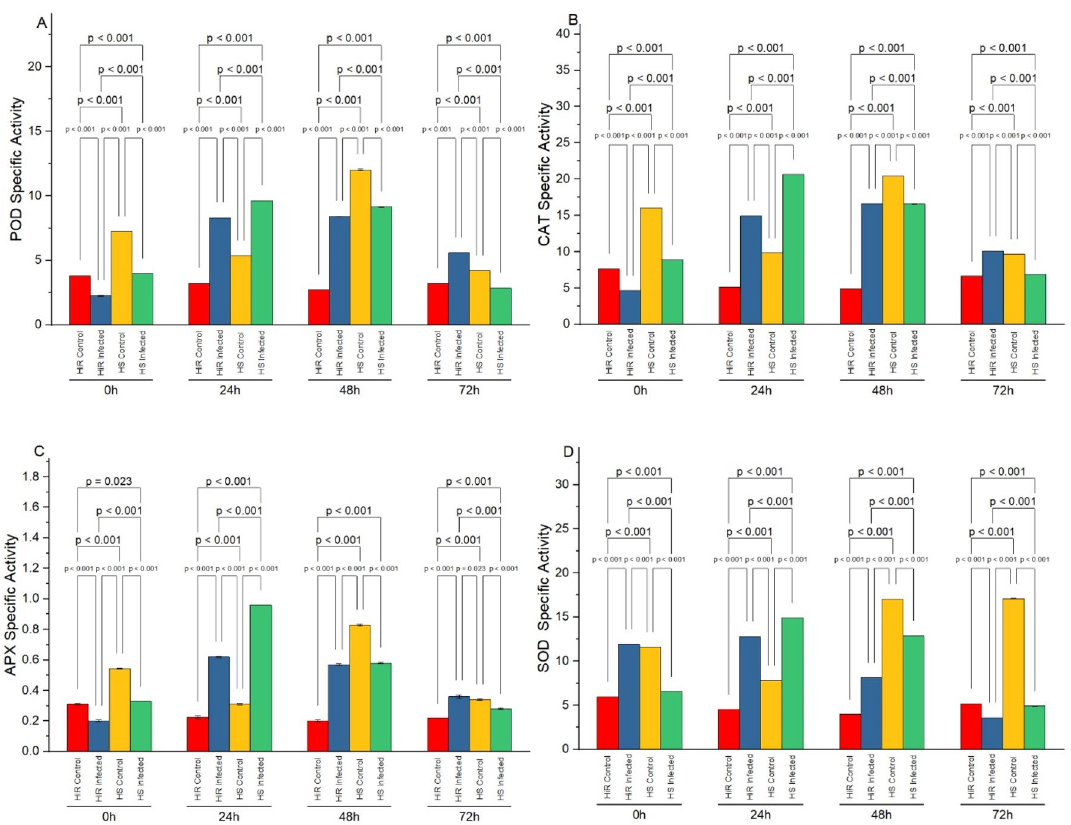
Figure 1. Specific activity of antioxidant ( A ) POD (U mg 1 Proteinmin 1 ) activity, ( B ) CAT (U mg 1 Proteinmin 1 ) activity, ( C ) APX (U mg 1 Proteinmin 1 ) activity, and ( D ) SOD (U mg 1 Proteinmin 1 ) activity in highly resistant (Hybrid) and highly susceptible (Padron) cultivars with and without Xanthomonas inoculation. Bar values indicates p-values at α <